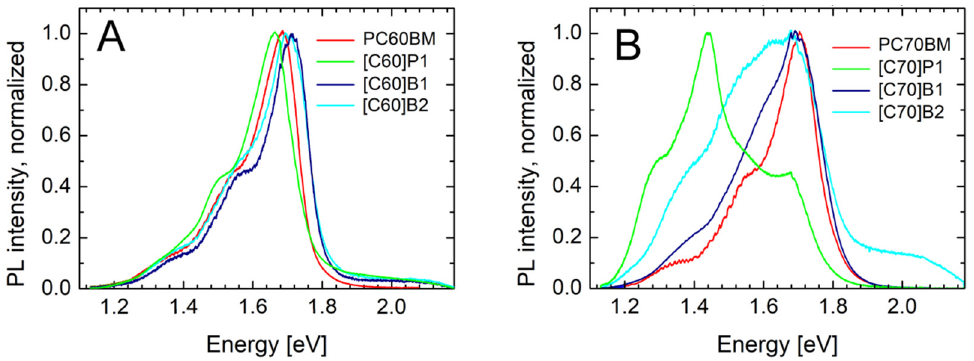
Figure 8. Luminescence spectra of the fullerene derivatives: ( A ) C 60 , ( B ) C 70 .